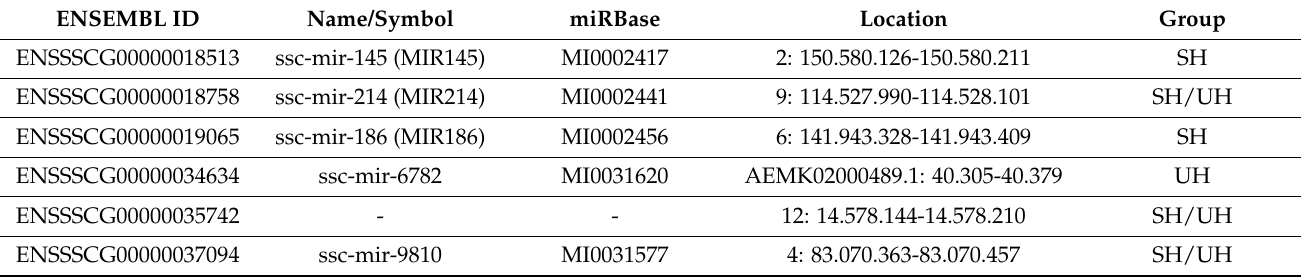
Table 11. miRNAs identified in the transcriptomes of the pig inguinal and umbilical ring tissues.